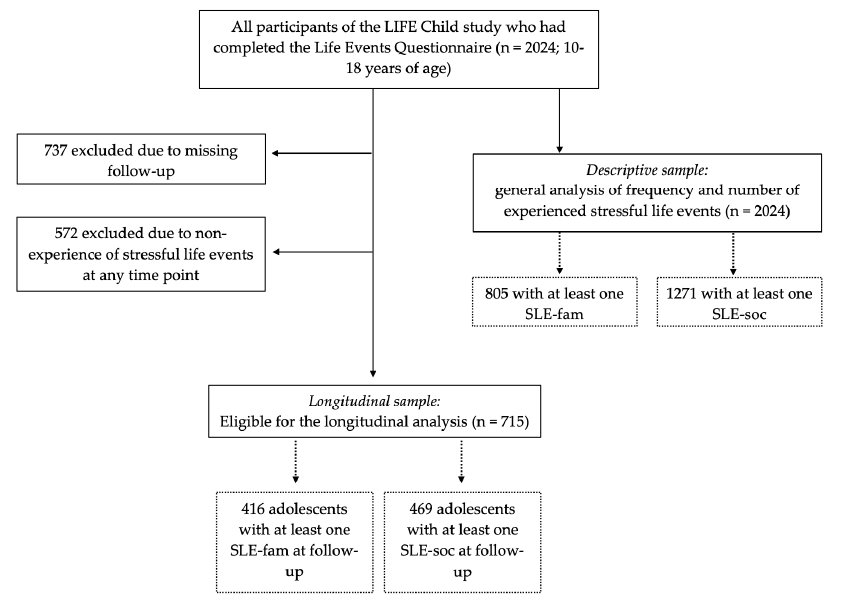
Figure 1. Flow chart of participant selection. SLE-fam: stressful life event in the family domain; SLE-soc: stressful life event in the social environment